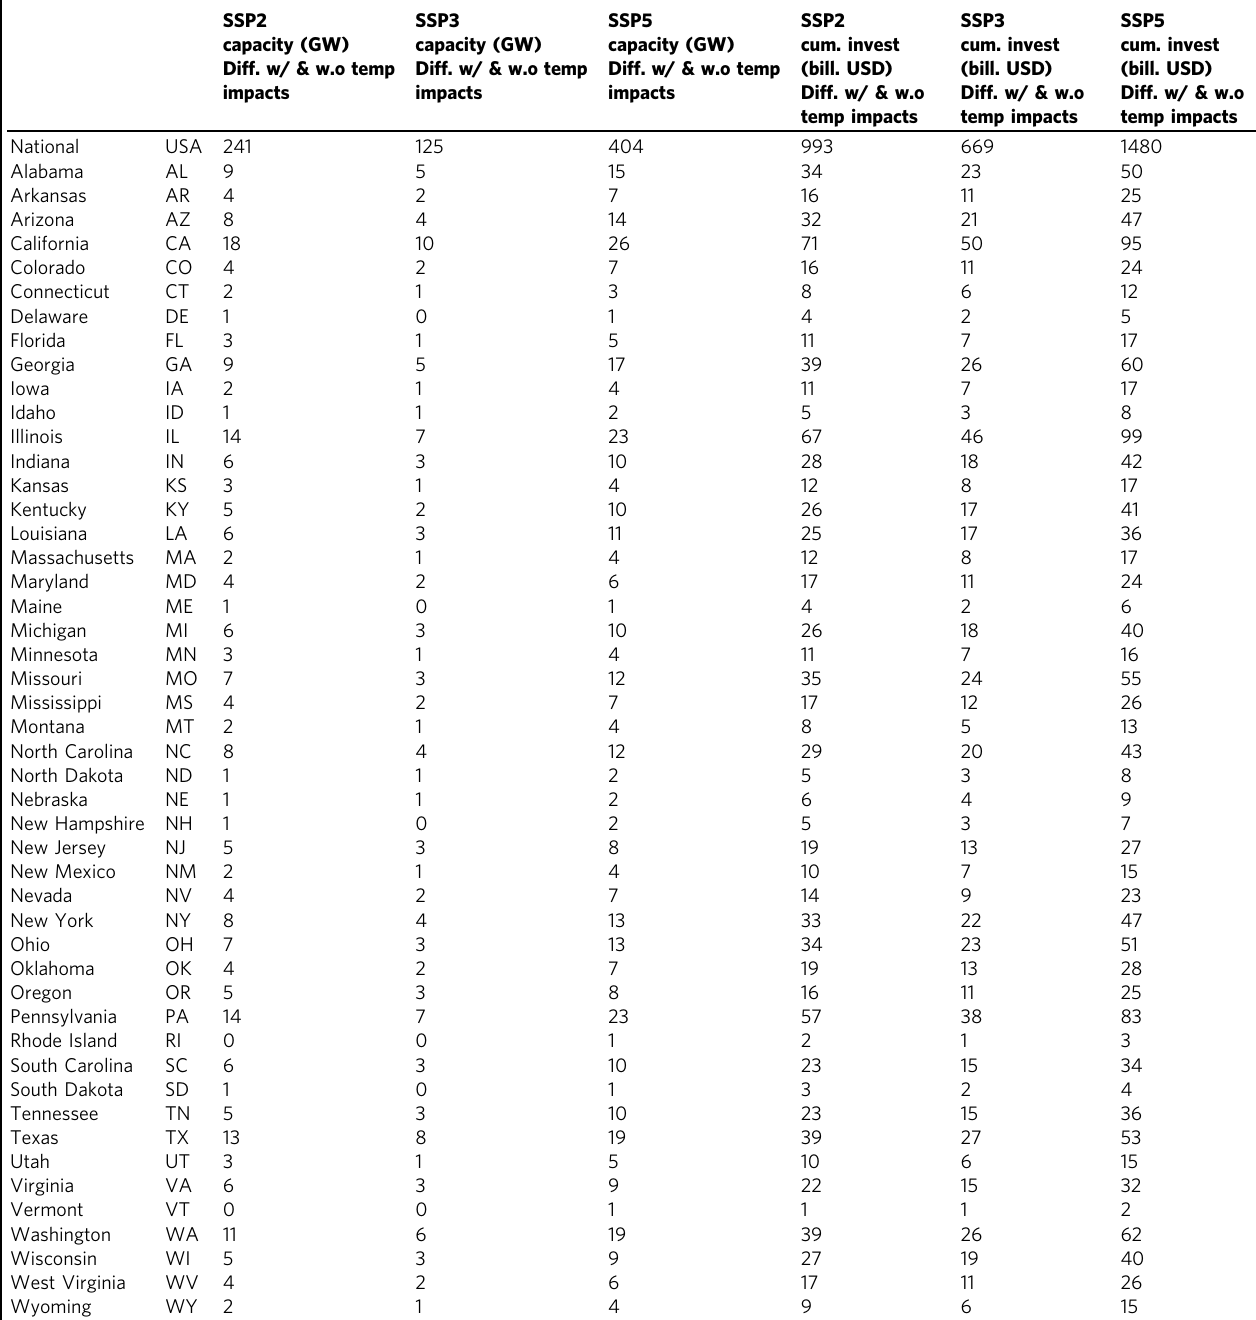
Table 2 Sensitivity of temperature-induced installed capacity in 2100 and cumulative capital investments (2015 – 2100) to socioeconomic